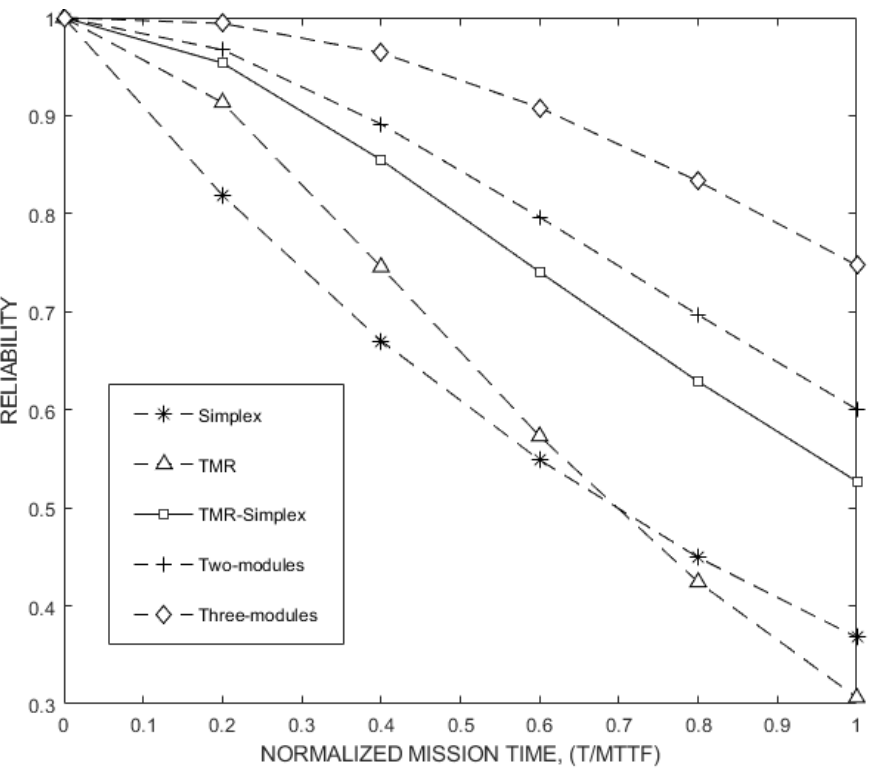
Figure 9. Reliability versus normalized mission time for Simplex, TMR, TMR/Simplex, and the proposed method for two- and three-module cases.